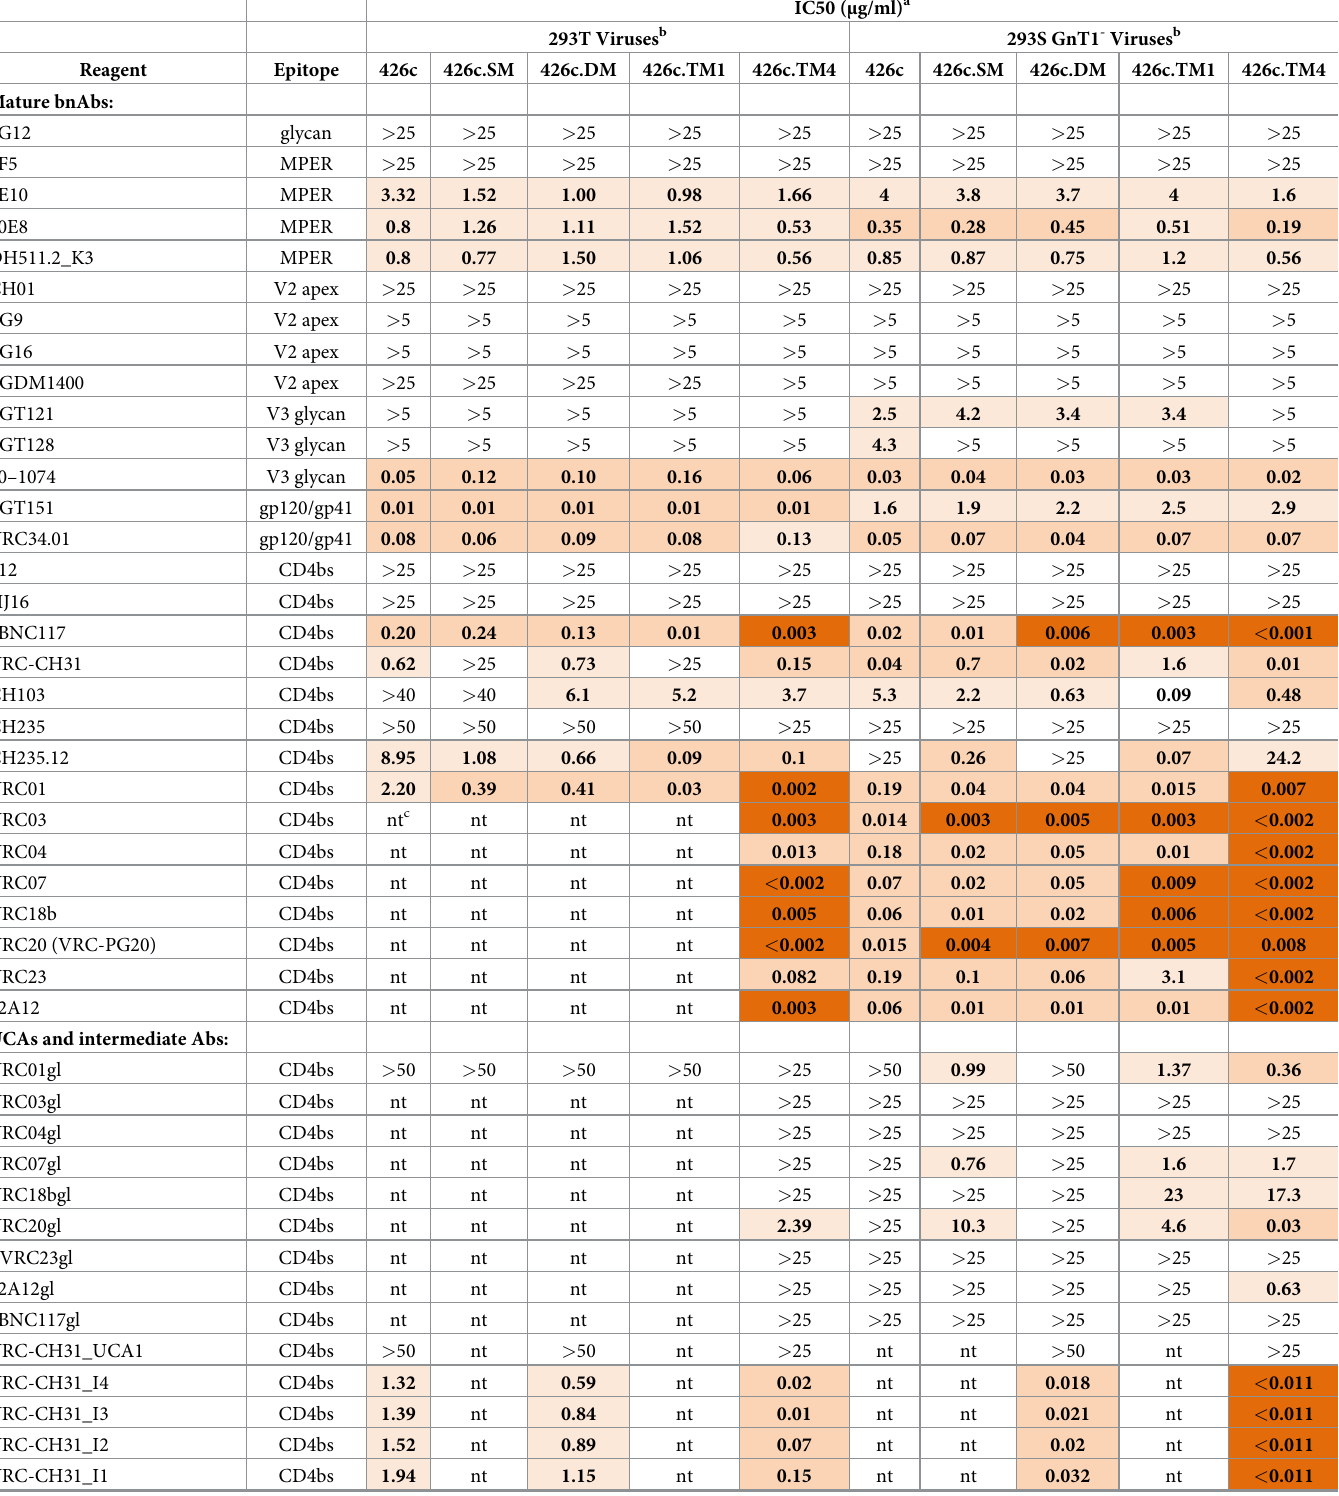
Table 4. Neutralization of parental and glycan-modified 426c by mature, intermediate and germline forms of